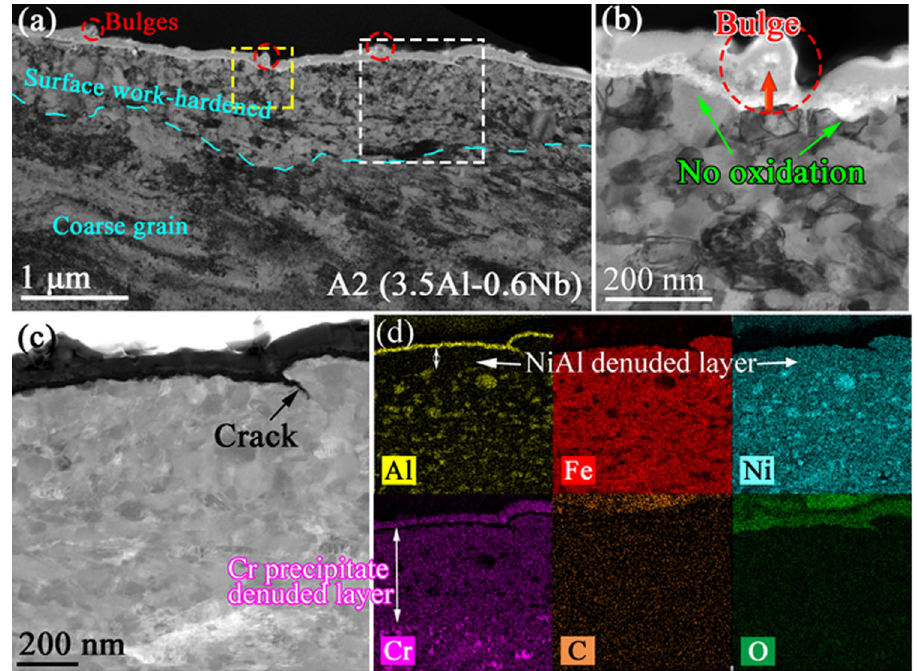
Fig. 6 TEM results of the surface oxide fi lm near the fracture of A2 sample. a BF image, b magni fi cation of the oxide fi lm inside the yellow frame in ( a ), c HAADF image inside the white frame in ( a ), d EDS mapping of ( c